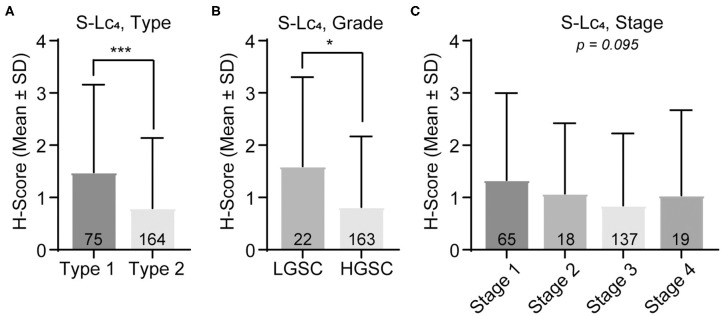
Assessment of S-Lc4 expression in ovarian carcinoma Type 1-2 and stage I-IV. (A) Assessment of the S-Lc4 expression in (A) Type 1 and Type 2 tumors. (B) Evaluation of the S-Lc4 expression in serous ovarian carcinoma, comparing LGSC and HGSC. (C) Evaluation of SL-c4 expression in different tumor stages. Data is presented as mean ± SD. Number of patients per group are indicated in the figure. Significant p-values are indicated as *p < 0.05, ***p < 0.0001. P-values were determined with Mann-Whitney test or Kruskall-Wallis with Bonferroni correction, where applicable. Number of patients in the groups are indicated in the figure.